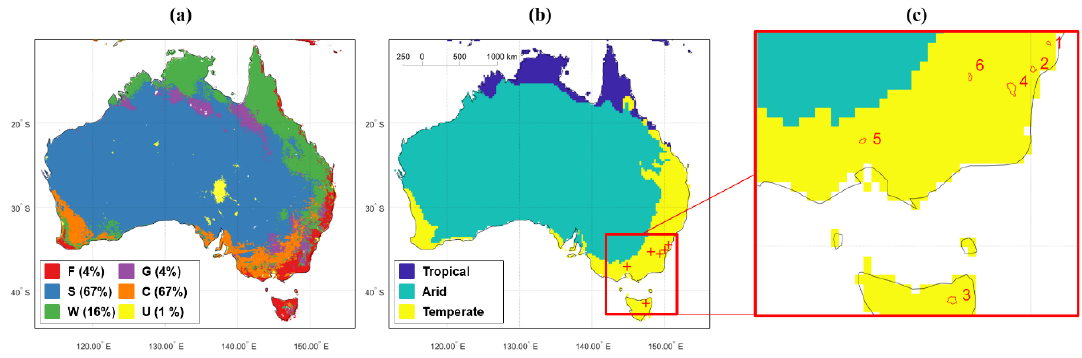
Figure 1. ( a ) Six primary land covers based on MODIS data (F = forest; S = shrublands; W = woodlands; G = grasslands; C = croplands; U = unvegetated regions) and ( b ) three dominant climate zones (tropical, arid and temperate) of Australia from the updated Köppen-Geiger climate classification. ( c ) locations and boundaries of six catchments used for SM and ET simulations in this study.